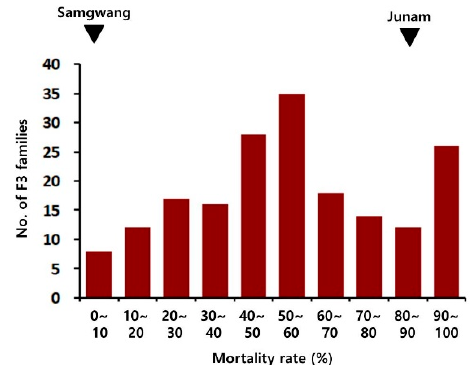
Figure 2. The distribution of the mortality rates of F2 plants obtained by crossing ‘Junam’ and ‘Samgwang’ seedlings. The mortality values for ‘Junam’ and ‘Samgwang’ plants are indicated on the histogram by solid inversed triangles.